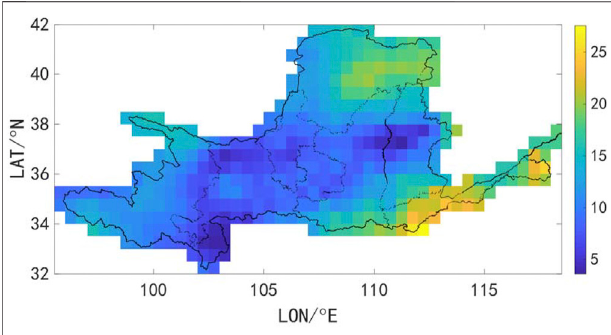
FIGURE4| Model spread distributionofthe fi veCMIP5 models over the Yellow River